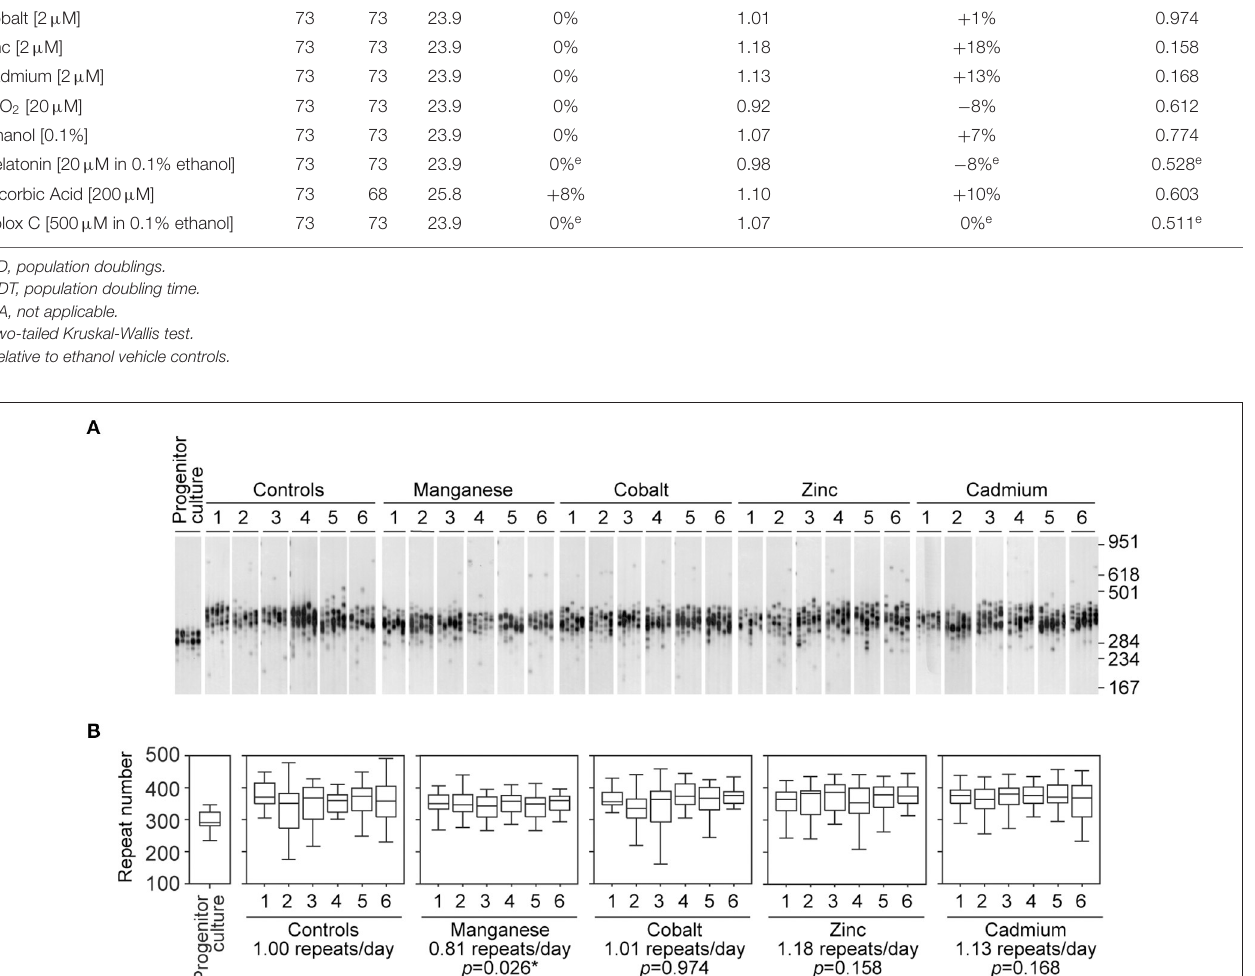
Change in Median expansion PDT (relative to rate (repeats/day)